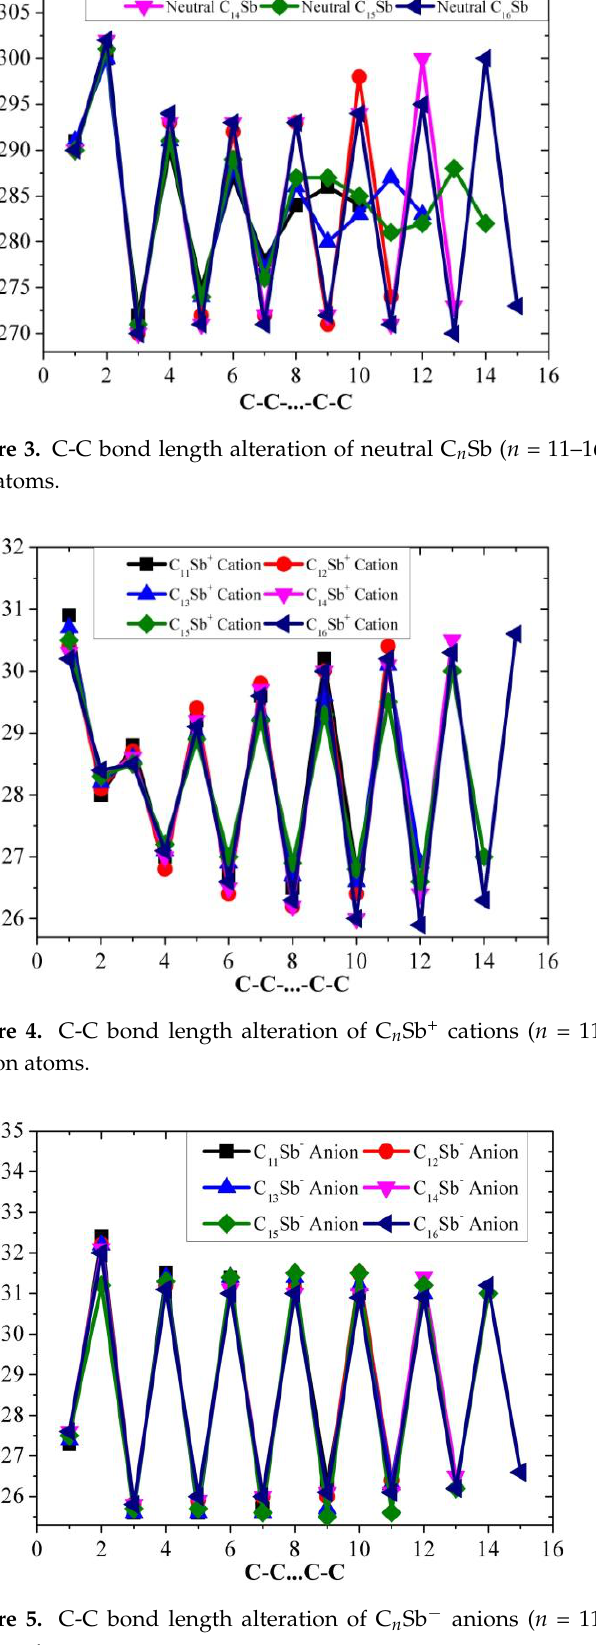
Figure 6. C-Sb bond length of neutral C n Sb, C n Sb + cation, and C n Sb − anion as a function of number of carbon atoms. We mainly focused on the linear carbon chain clusters initially because many re- ported carbon clusters mainly adopt a linear shape as the ground state structure. For the antimony-doped larger carbon clusters (n > 10), we conducted density functional calcu- lations to obtain the energies of ring structures. The total energies of C 11 Sb and C 14 Sb with a ring structure are 0.35 and 0.11 eV higher in energy than linear C 11 Sb and C 14 Sb clusters, while C 12 Sb, C 13 Sb, C 15 Sb, and C 16 Sb clusters with a ring structure are − 0.14, − 0.57, − 0.53, and − 0.83 eV lower in energy. Although the linear carbon cluster is not al- ways the global minima in the potential surface, the linear carbon clusters possess a practical significance that the reactivity of carbon clusters increases dramatically with the increasing number of consecutive cumulene-like double bonds, and the linear carbon clusters can be formed in space-confined nanotube materials [33 – 35]. The linear carbon chain cluster with different lengths and doping atoms is a special allotrope type of car- bon material different from graphite, diamond, graphene, carbon nanotubes, and fuller- enes. We made comparisons between 6-31G(d) and def2-TZVP basis sets for selected structural parameters, C-Sb stretching frequencies, and HOMO-LUMO gaps in Table 7. The C-C bonds adjacent antimony atoms of C 4 Sb, C 5 Sb, C 6 Sb, C 10 Sb, and C 11 Sb show only